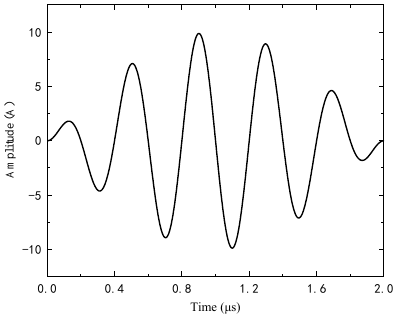
Figure 5. Time domain waveform of EMUS excitation current signal.